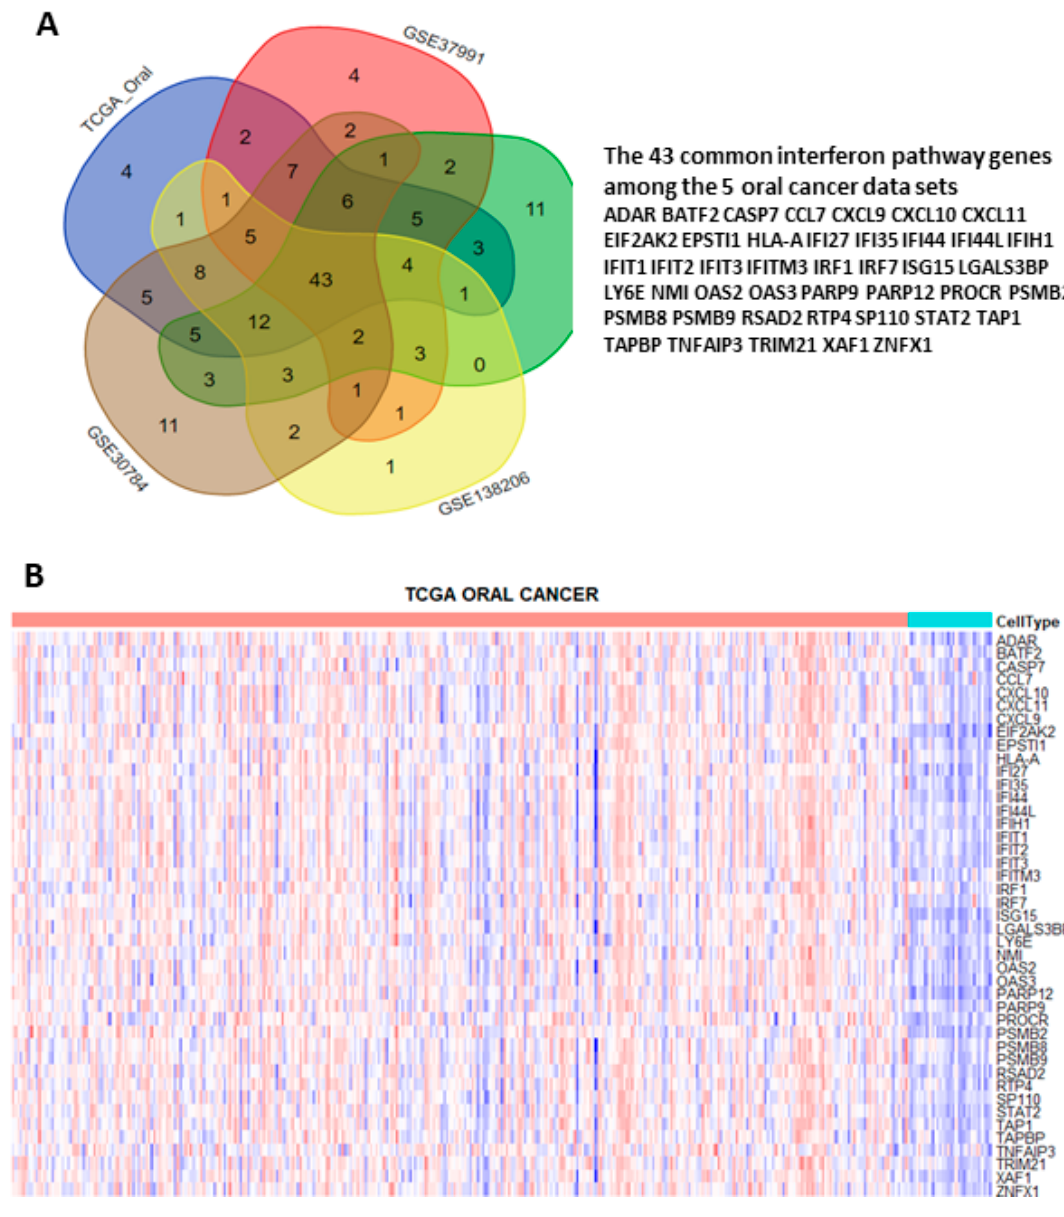
Figure 3. Identification of the 43 interferon pathway genes commonly upregulated in the 5 oral cancer data sets. ( A ) Intersection of the core enriched genes in interferon- α and interferon- γ pathways of each data set. ( B ) Heat map showing the differential expressions of the 43 common interferon pathway genes in tumor (T) and normal (N) tissues of TCGA oral cancer data set.